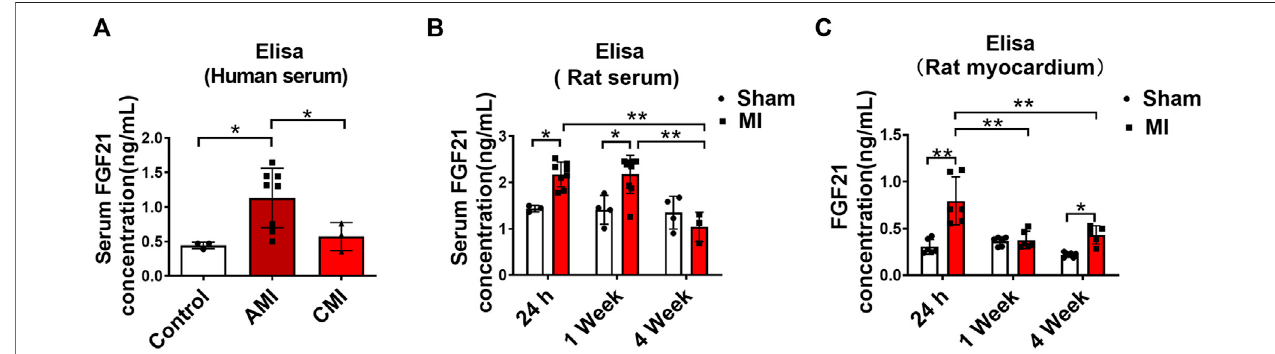
FIGURE 1 | SerumFGF21levelsinpatientsand ratswithmyocardialinfarction. (A) TheFGF21levelsinperipheralblood serumfromhealthy volunteers(Control, n (cid:1) 3) and myocardial infarction (MI) subjects ( n (cid:1) 8) on the fi rst day (AMI) and 7th-10th day (CMI, n (cid:1) 3). Two-tailed Student ’ s t -test was performed, * p < 0.05. (B) Comparison of serumFGF21levelsinratsbetweenMIandshamoperationgroup(sham). n (cid:1) 3 – 7,* p < 0.05and** p < 0.01. (C) ComparisonofFGF21levelsinrathearttissuesbetweenMI and sham group. n (cid:1) 6, * p < 0.05 and ** p <